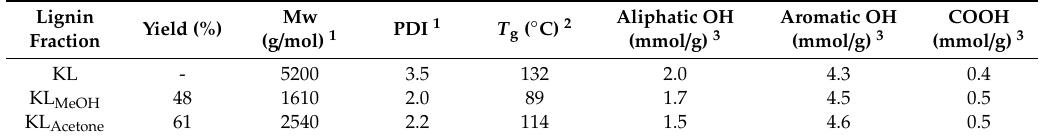
Table 1. Characterization of lignin